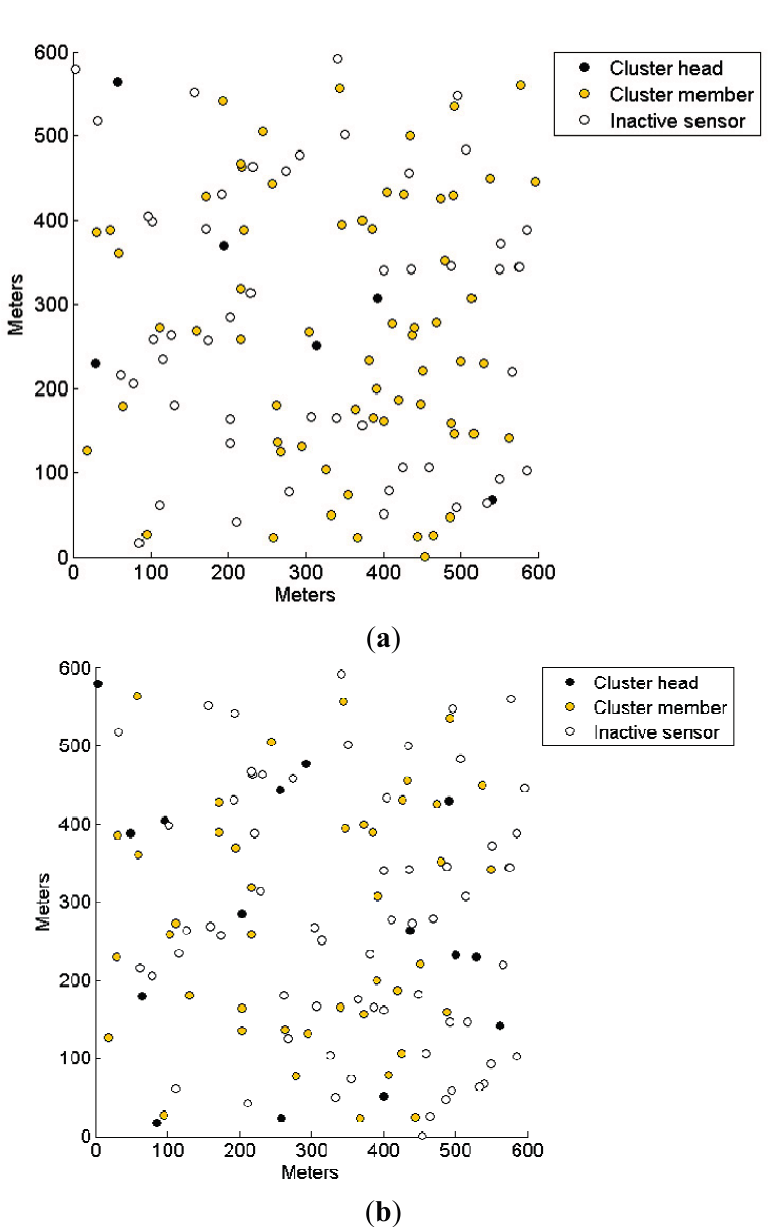
Figure 10. Network composition when half of the sensor nodes are alive for ( a ) CENTRE and ( b )